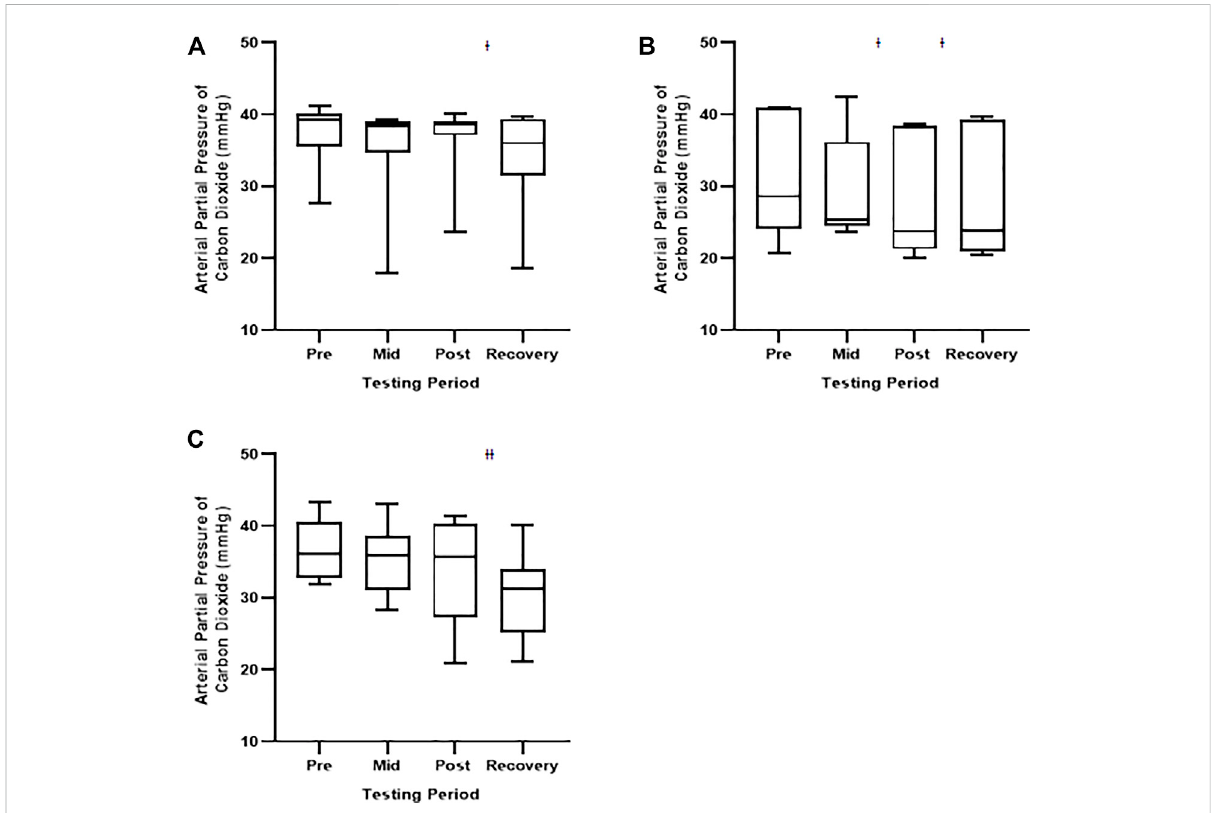
FIGURE 3 Arterial partial pressure of carbon dioxide during the 30 s, 60 s, and 120 s oscillation exposures. Values represent means ± SD. (A) depicts the 30 s oscillations; (B) depicts the 60 s oscillations; and (C) depicts the 120 s oscillations. Signi fi cant difference from the Pretesting period, p < 0.05. Ɨ Signi fi cant difference from the Pretesting period, p <